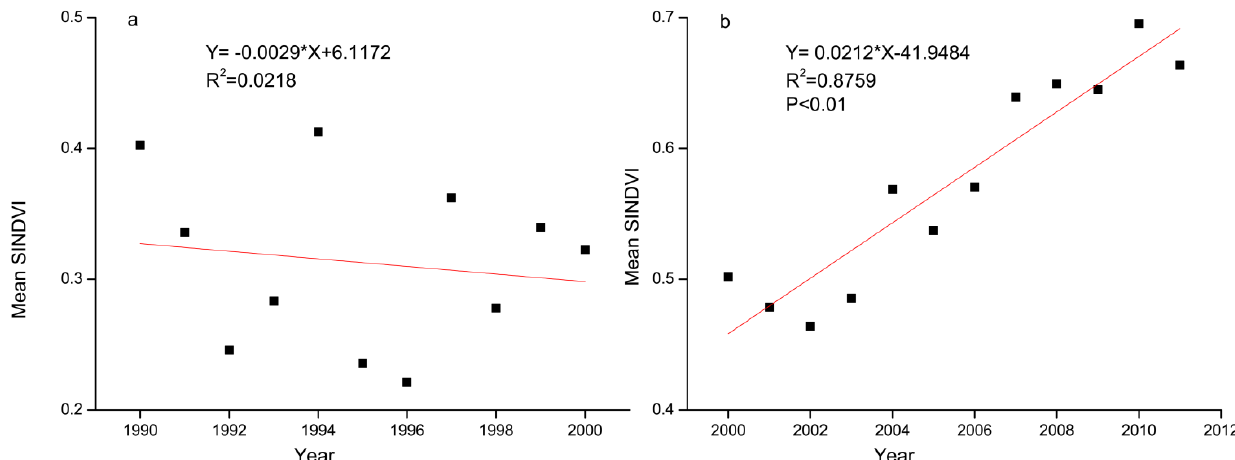
Figure 6. Long-term SINDVI changes in the Ejin Oasis between 1990 and 2011: ( a ) SINDVI changes between 1990 and 2000 were based on GIMMS NDVI data, and ( b ) SINDVI changes between 2000 and 2011 were based on MODIS NDVI data.